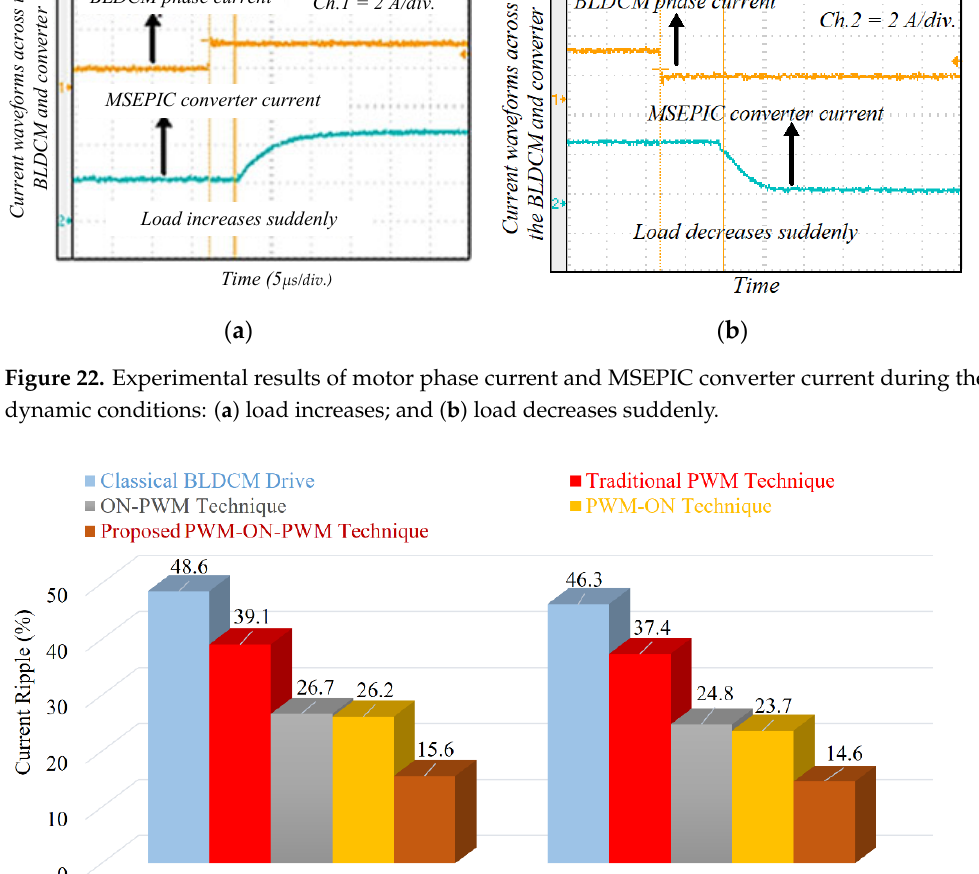
Figure 23. Comparative study of different techniques with proposed method.